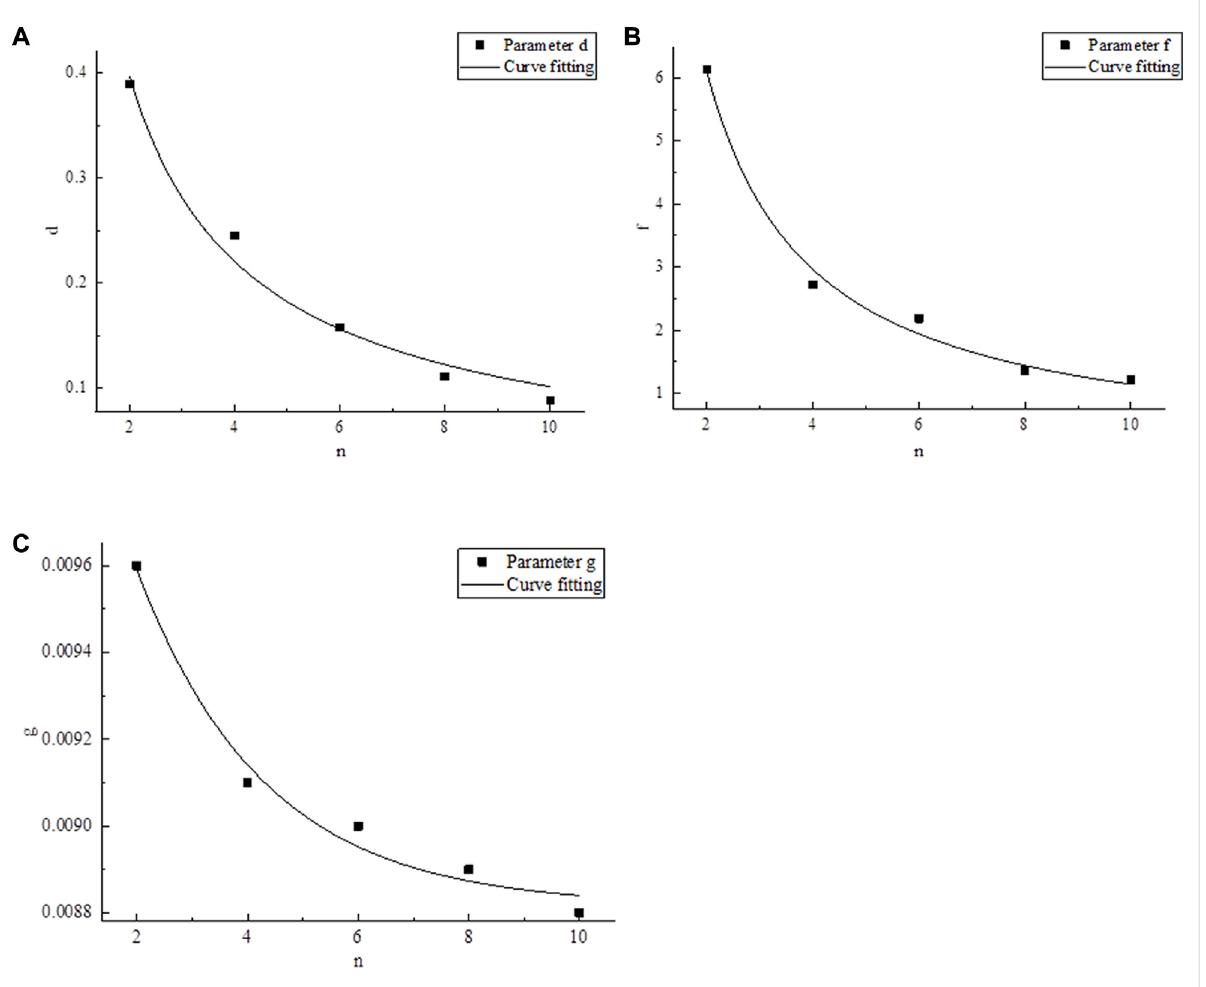
FIGURE 6 Fitting curve diagram of parameters: (A) parameter d , (B) parameter f , and (C) parameter g .